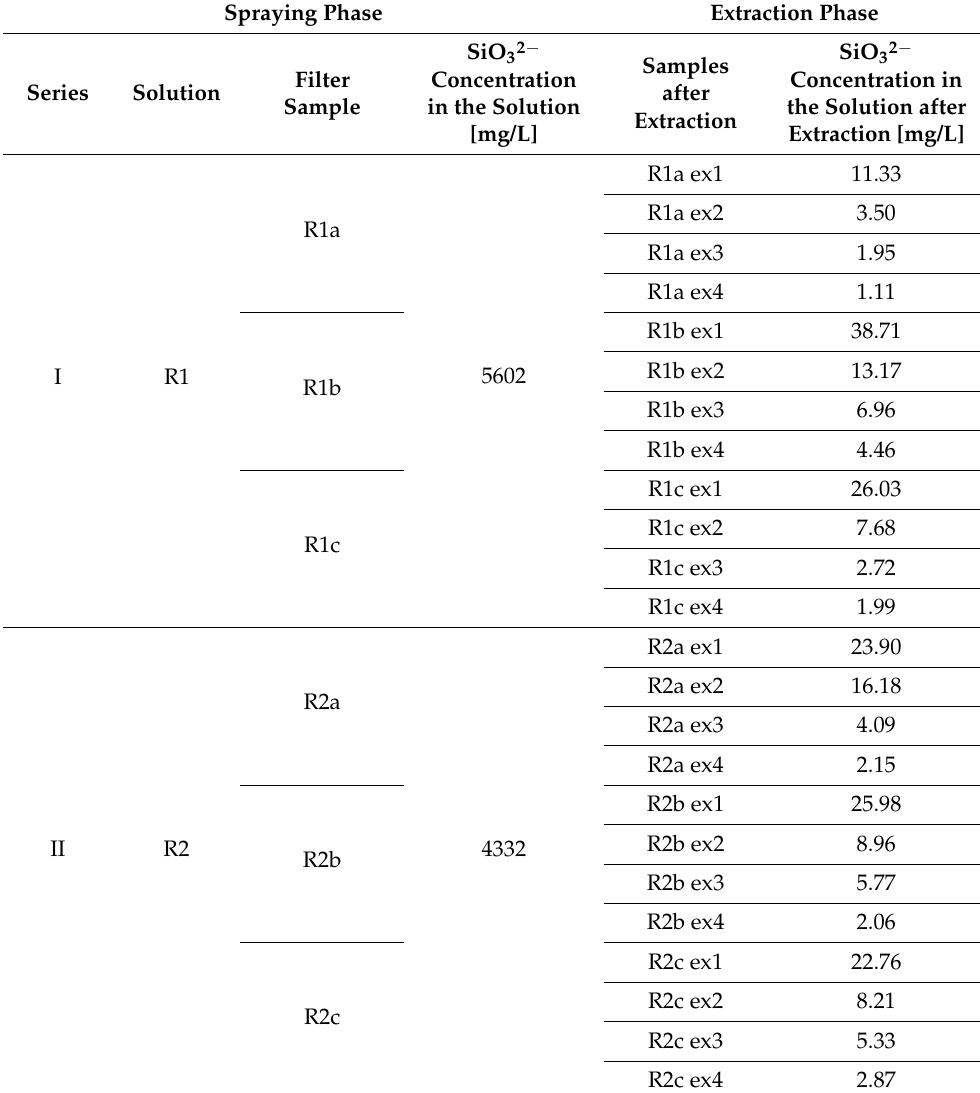
Table 5. Marker concentrations in the solutions after extraction using 5 mL of 1% ethanol solution.